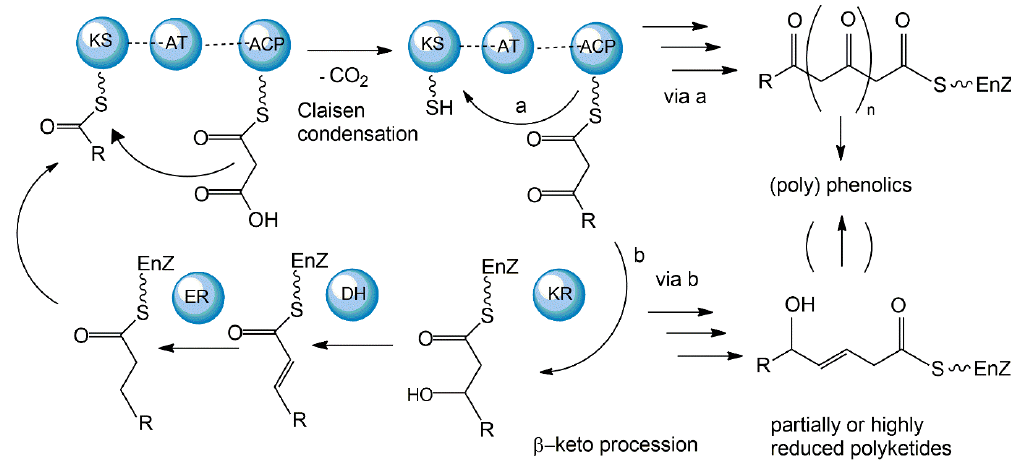
Figure 6. Mechanisms of fungal polyketide biosynthesis.